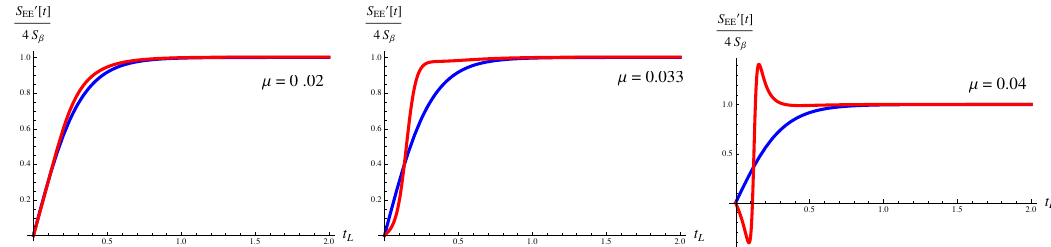
Figure 4 . The speed of entanglement entropy growth v for three values of (cid:22)=(cid:12) with (cid:12) = 1 for convenience, and taking the interval length ‘ (cid:29) 1. When (cid:22) > 0 : 033, v approaches unity from above. The blue curve is for (cid:22) = 0 and the red curve is for (cid:22) 6 = 0.